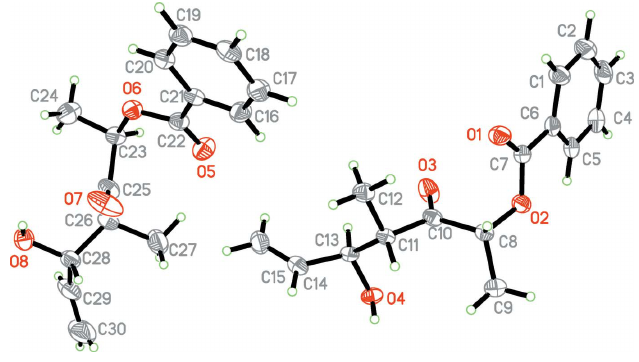
Figure 1 The molecular structure of the title compound, showing the labeling of all non-H atoms. Displacement ellipsoids are shown at the 50% probability level. The asymmetric unit contains two